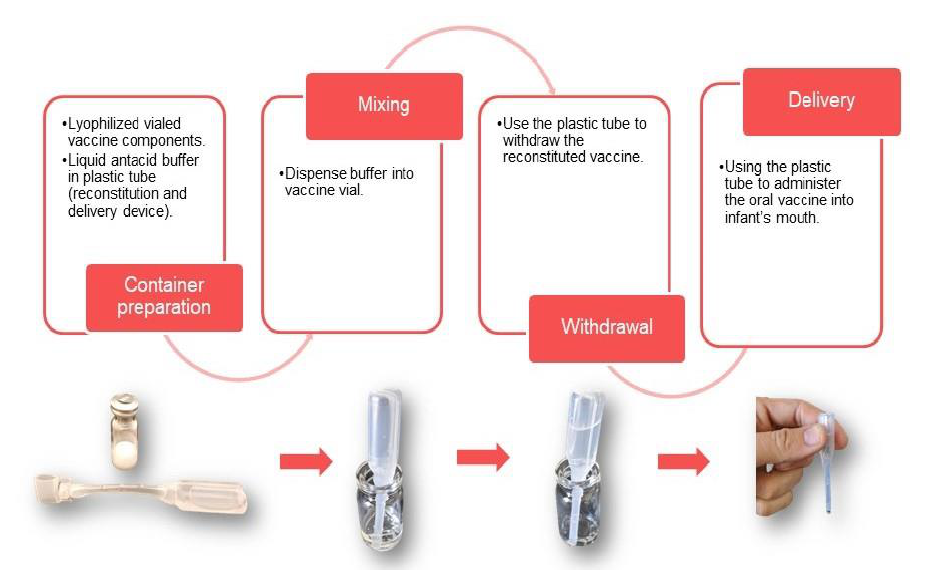
Figure 3. Presentation options for oral enteric vaccine delivery. Oral vaccine presentations can be made up of a combination of dry and liquid vaccine components that can be combined as Table